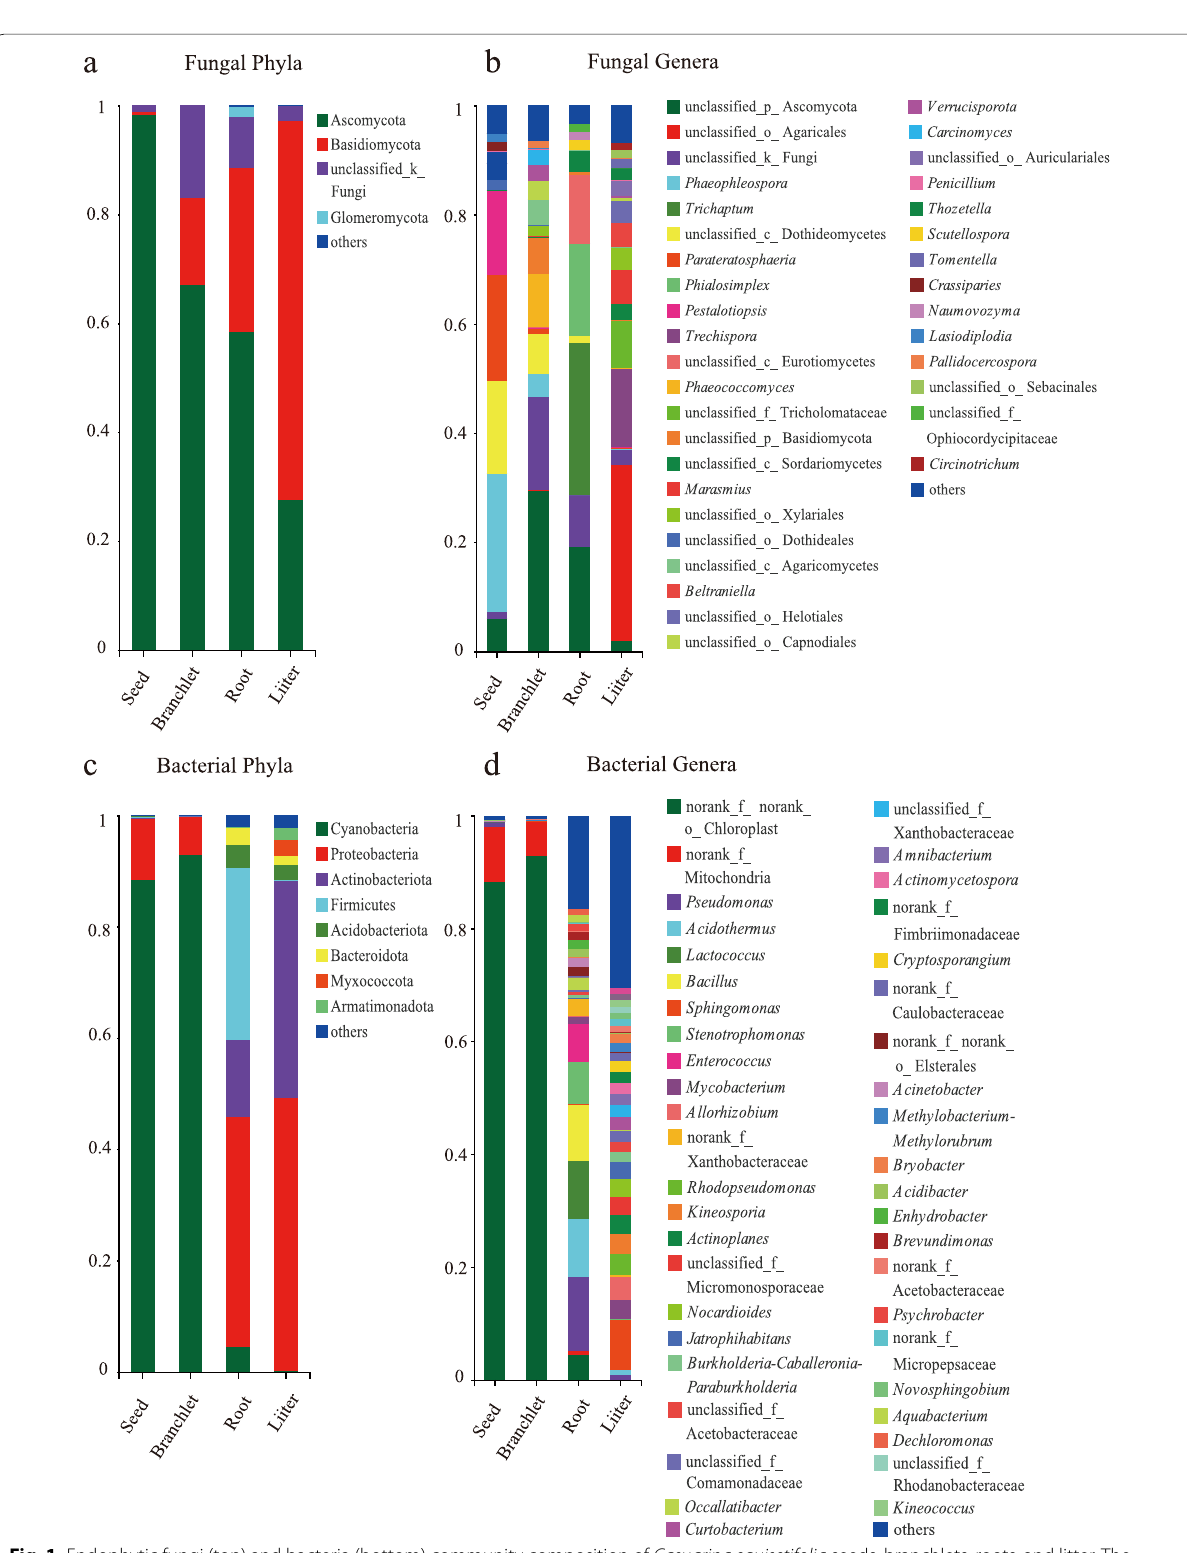
Fig. 1 Endophytic fungi (top) and bacteria (bottom) community composition of Casuarina equisetifolia seeds, branchlets, roots, and litter. The abscissa represents different ecological niches and the ordinate represents the relative abundance of microbial